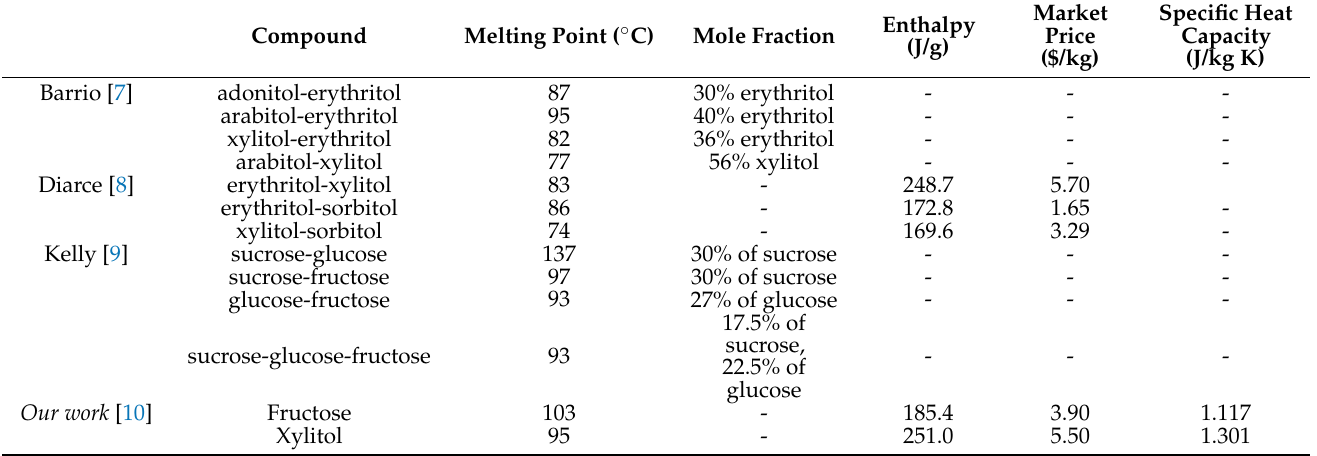
Table 1. Properties of sugar mixtures for heat storage at low to medium temperatures. Compound Melting Point ( ◦ C) Mole Fraction